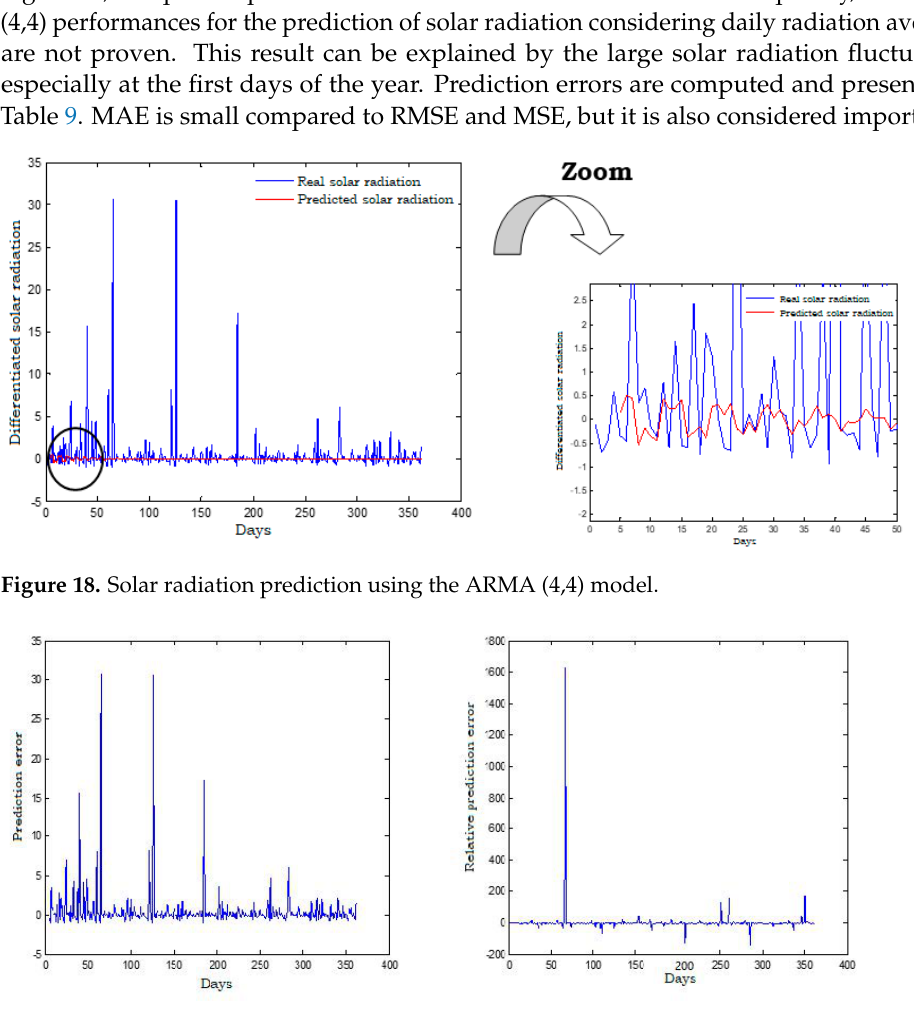
Figure 17. ( a ) Error and ( b ) relative error of the prediction of solar radiation using the ARMA (4,4) model. Table 8. MSE, MAE, and RMSE of the prediction of solar radiation using the ARMA (4,4) model.